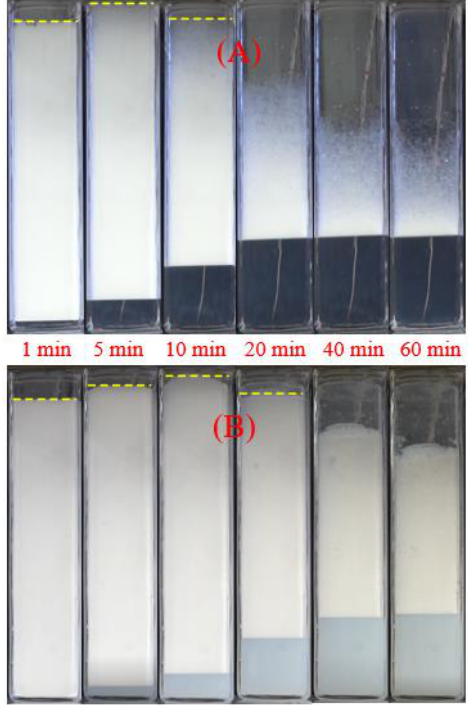
Figure 3. The appearance change of the foams exposed to thermal radiation: ( A ) A-0#; ( B ) A-2#. In order to quantitatively analyze foam stability, the variation in foam height and drainage height of the dispersion under thermal radiation versus time is plotted in Figure 4. Overall, the foam drainage curves of the five groups of gel dispersions rise and then flatten gradually. The foam drainage curves of the mixed dispersions descend rapidly with the increase in NP concentration. Among them, the drainage curves of A-4# have extremely small variation and are much lower than the other four groups of curves. In contrast to the foam drainage curves, the foam height curves decrease following a short increase over time. The short increase is corresponding the foam expansion during foam thermal stability experiment. The foam height curves rise gradually with increasing NP concentration. The foam decay curves of A-1#, A-2# and A-3# are relatively close. The foam decay curve of A-0# is much lower than other curves. The foam height curve of A-4# is much higher than other four groups. After 60 min, the foam height of A-4# is higher than its initial value. This is because the foam of A-4# decays and drains out liquid very slowly after foam expansion. The increase in foam volume due to gas expansion under heat has not disappeared after 60 min yet. The result demonstrates that the gel foam containing NPs with a high concentration is highly stable under thermal